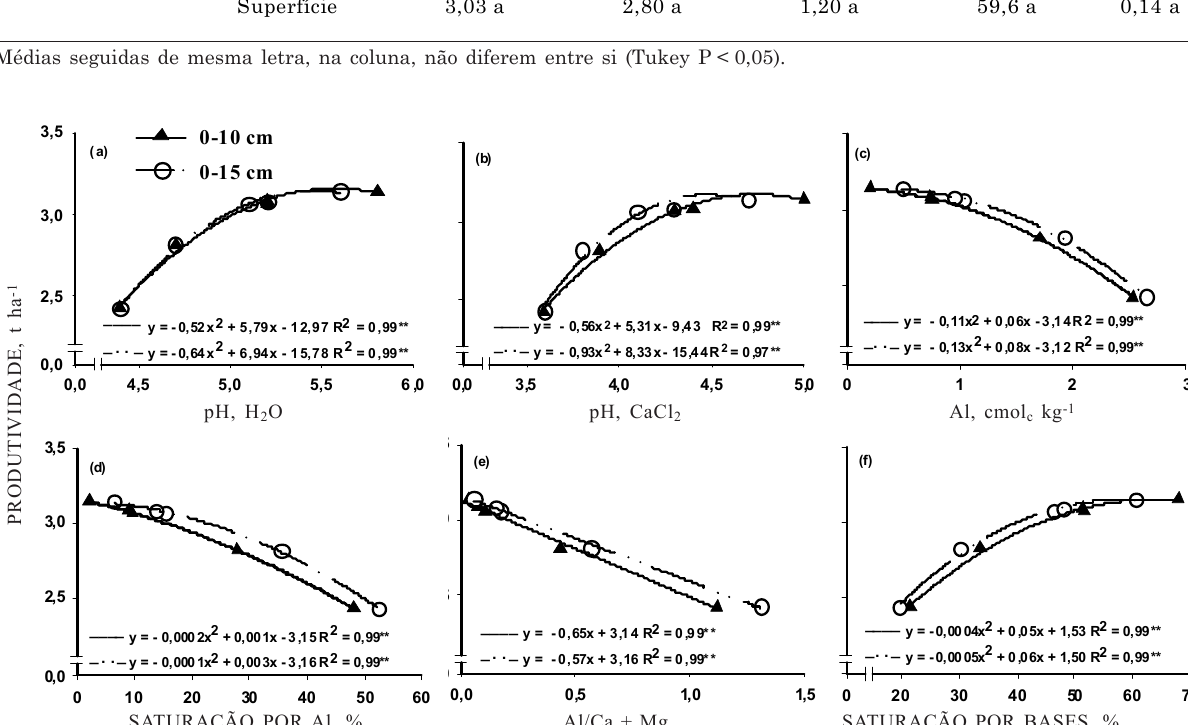
Figura 1. Relação entre a produtividade de grãos e o pH H Al (d), relação Al/Ca + Mg trocáveis (e) e saturação por bases (f) em duas camadas de um Latossolo Vermelho aluminoférrico típico cultivado por oito anos no sistema plantio direto, após a aplicação de calcário em área de lavoura